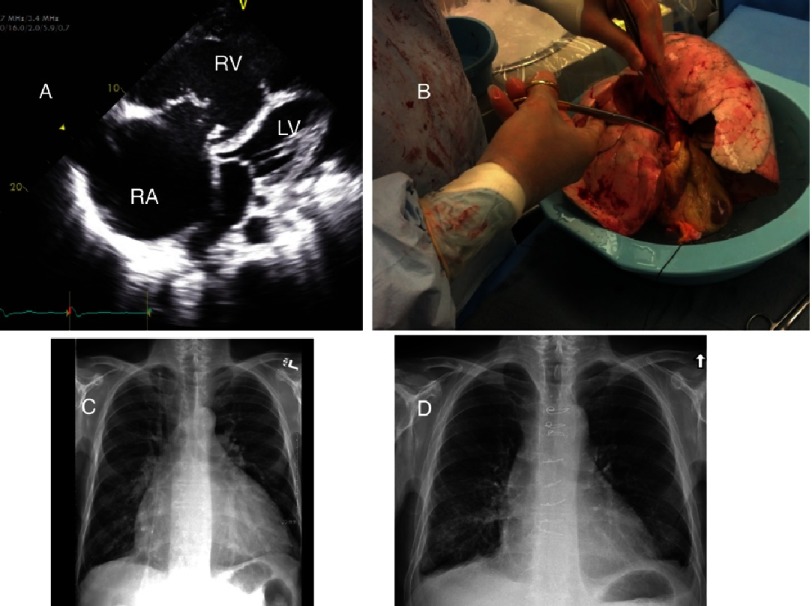
55 year-old male with Idiopathic Pulmonary Arterial Hypertension and severe refractory right heart failure despite therapy with intravenous epoprostenol, requiring continuous ambulatory dopamine infusion for inotropic support.Apical 4-chamber echocardiographic view (A) demonstrates massive dilatation of the right atrium (RA) and right ventricle (RV) impairing left ventricular (LV) filling. The patient underwent a combined heart-lung transplant (B) and is asymptomatic with normal cardiac and pulmonary function 2 years post-transplant. Chest radiograph pre (C) and post (D) transplant.